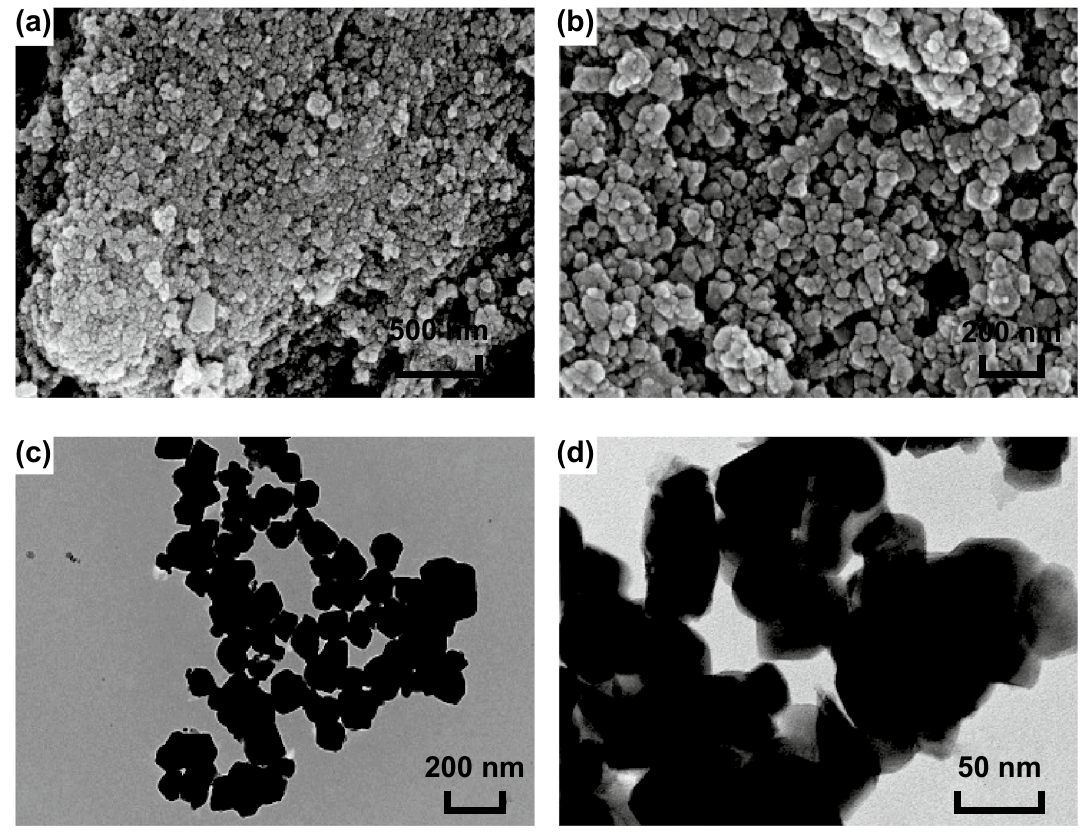
Fig. 1 a , b SEM and c , d TEM images of the CoMn 2 O